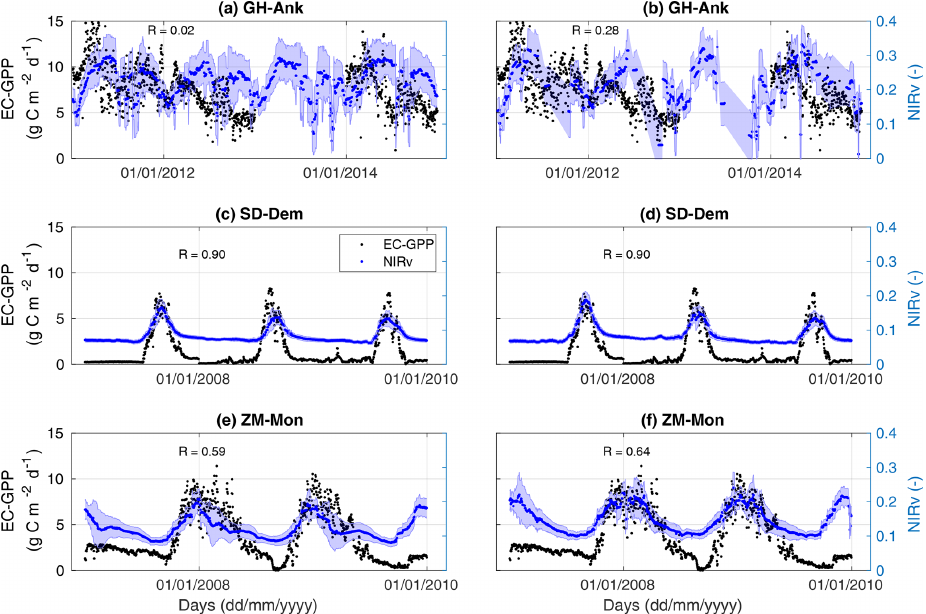
Figure 3. Comparison of coarse NIRv at 0 . 5 ◦ × 0 . 5 ◦ (left panels) and high-resolution NIRv at 0.05 ◦ × 0 . 05 ◦ (right panels) with flux-tower- measured GPP (EC GPP) for a selection of three African flux towers (GH-Ank, SD-Dem, and ZM-Mon). The temporal correlation between NIRv and EC GPP is given in each panel.